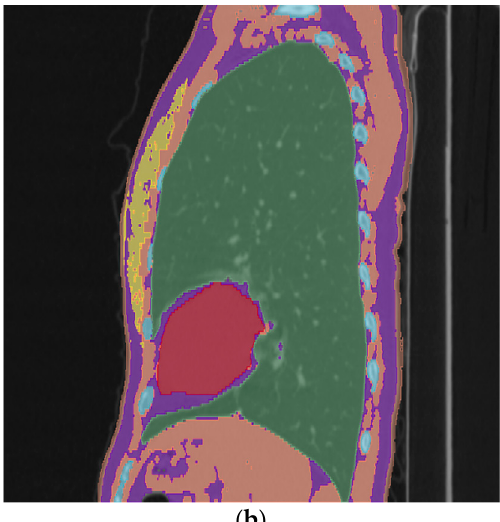
Figure 1. An example within the chest CT image sequences used to create voxelized patient model, where different colors represent the heart wall, muscle, bone, fat, and skin segmented by the 3D Slicer software: ( a , b ) are the transverse and sagittal axial image of the patient, respectively.